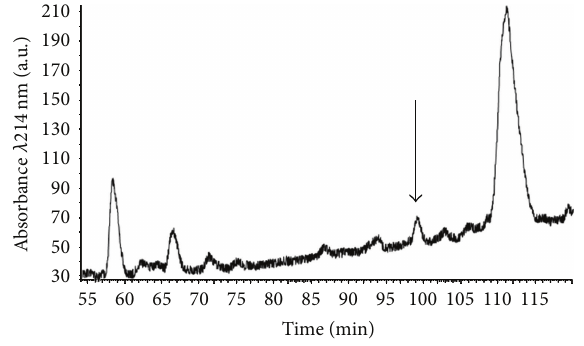
Figure 1: Region of reverse phase HPLC chromatogram of Pelo- phylax plancyi fukienensis skin secretion indicating elution posi- tion/retention time of the peak of absorbance corresponding to bradykinin inhibitory activity